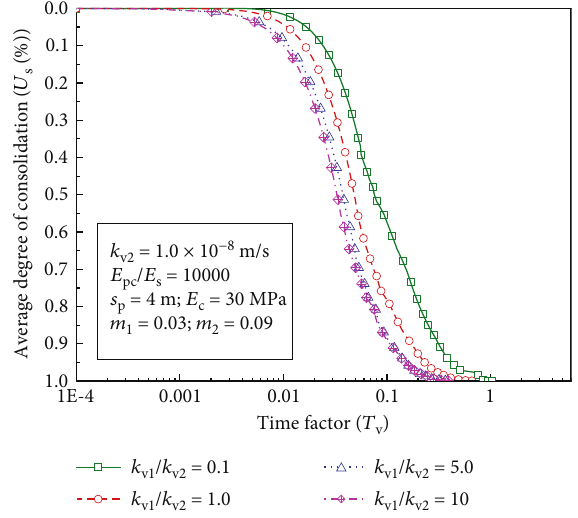
Figure 12: E ff ect of k